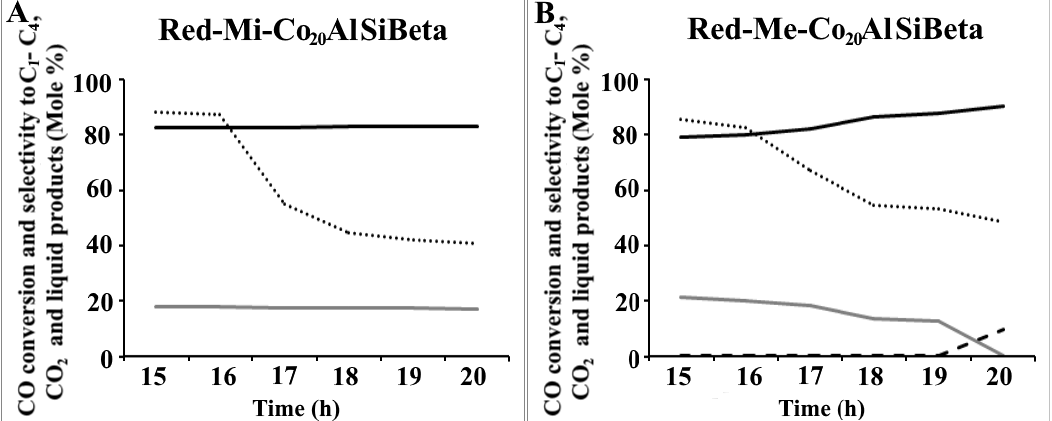
Table 3. The catalytic performance of tested samples after 20 h of reaction.